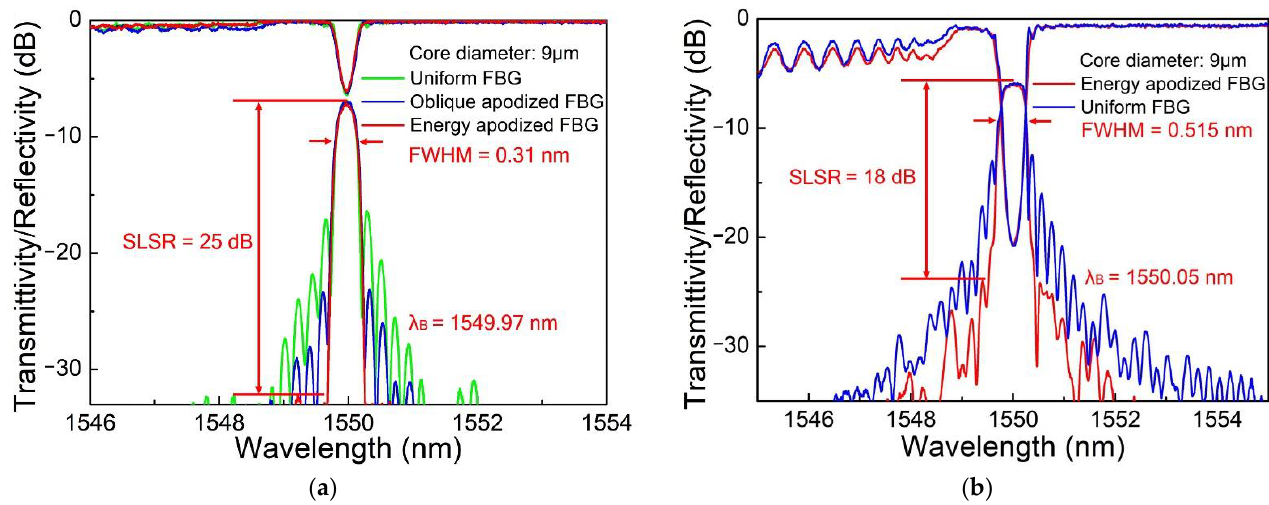
Figure 3. ( a ) Comparison of a uniform FBG spectrum and an apodized FBG spectrum with a reflectivity of 75% fabricated by two methods in fibers with a core diameter of 9 μm. ( b ) Comparison of a uniform FBG spectrum and an apodized FBG spectrum with a reflectivity of 99% fabricated by an energy regulation method in fibers with a core diameter of 9 μm.